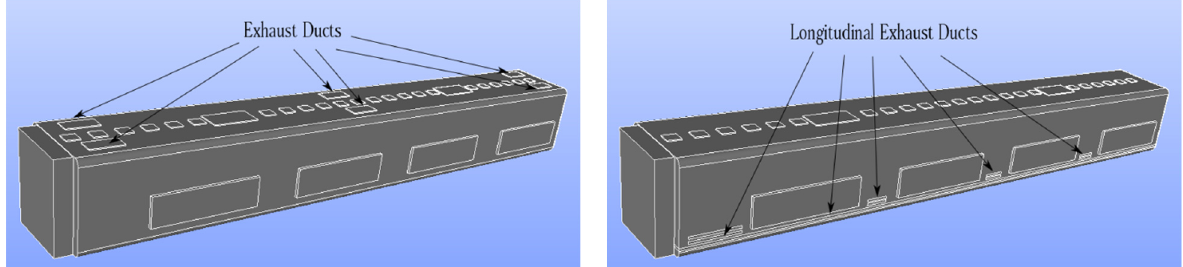
Figure 7. Comparison between a conventional ( left side ) and the proposed ( right side ) HVAC sys- tems for an urban subway cabin.